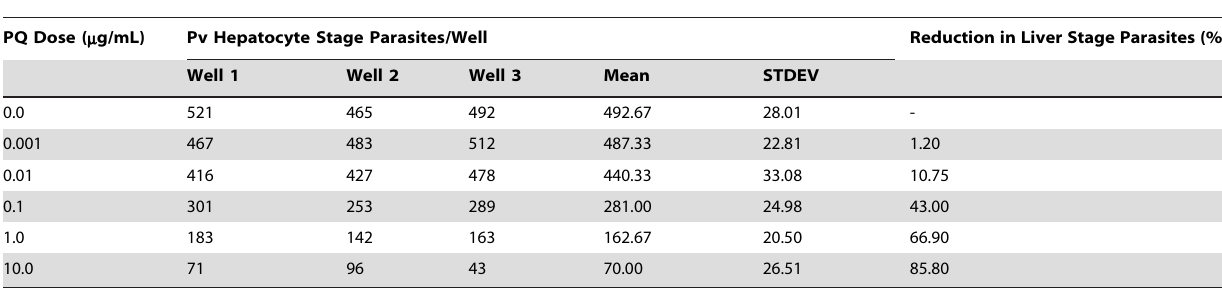
Table 4. Dose dependent effect of primaquine on the development of 9 day hepatocyte stage parasites.